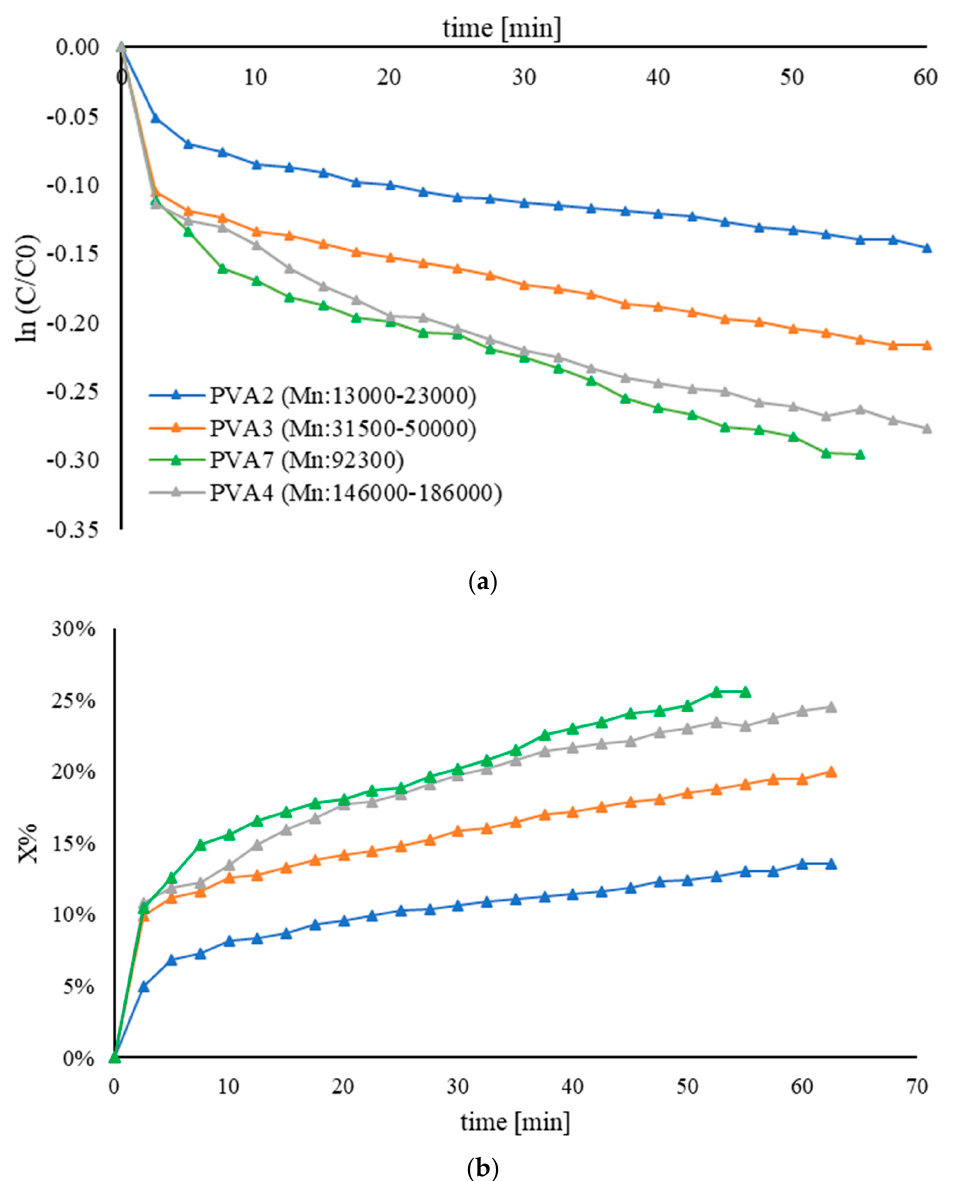
Figure 2. ( a ) Pseudo–first–order kinetic plot and ( b ) conversion plot for the comparison of the activity of Au/AC synthesized using PVA with different molecular weights. The reduction of 4–NP was carried out using 25 mL of 4–NP (2 × 10 − 4 M), 25 mL of NaBH 4 (9.0 × 10 − 3 M), an Au/PVA weight ratio of 1:0.65, 4 mg of catalyst, at 25 °C. Table 7. Values of the apparent constant and conversion for pseudo-first-order reactions using PVA with different molecular weights.